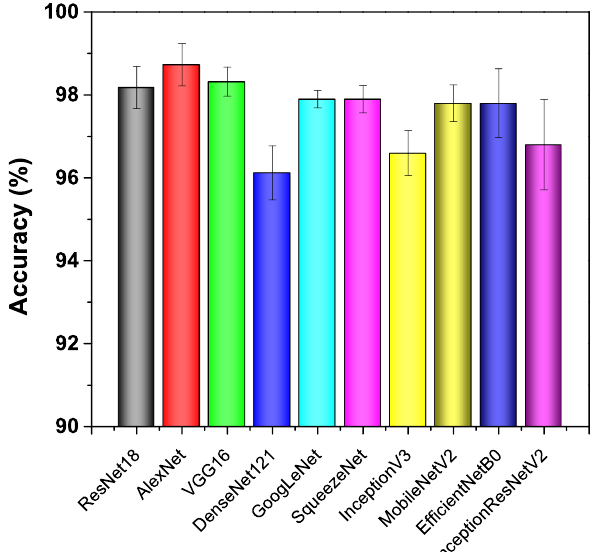
Figure 4. The graph representation of classification accuracy (mean) for pre-trained CNN models. Error bars represent standard deviation (SD).